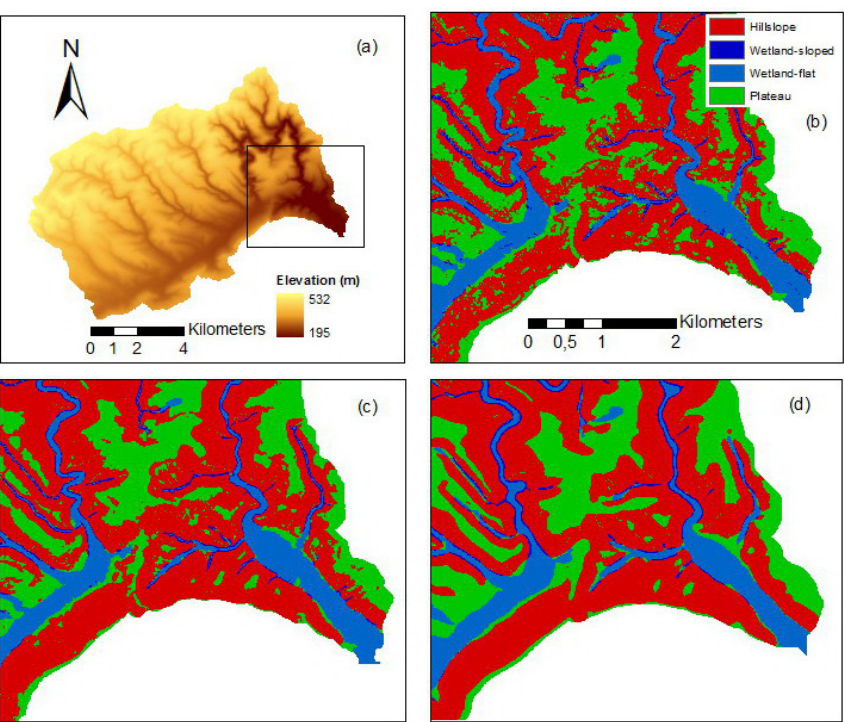
Fig. 7. Smoothing window effect on the land classification for the model M SHopt . (a) Location of selected area in the Wark catchment; (b) classified landscapes for original DEM with resolution of 5m × 5m without using a smoothing window; (c) classified landscapes using a smoothing window of 60m ( σ =10m); (d) classified landscapes using smoothing window of 300m ( σ =50m).